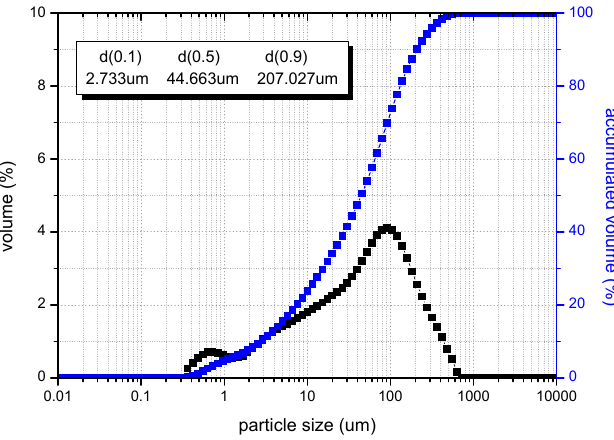
Table 3. Properties of waste concrete powder (WCP) and silica powder.